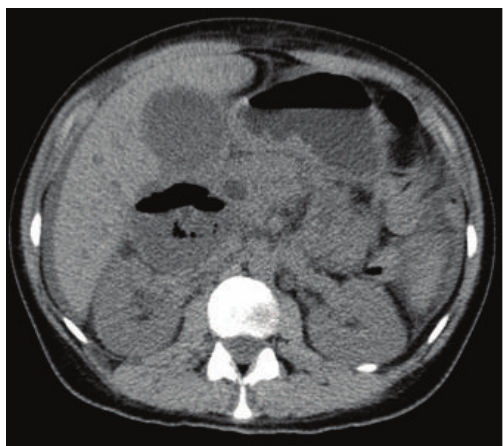
Figure 3: CT scan slice showing the air-fluid filled cyst.